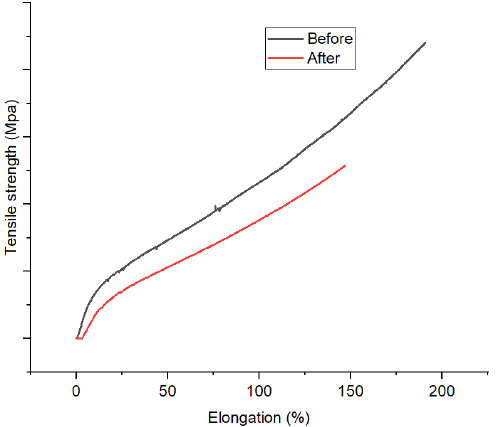
Figure 13. Mechanical profile 1,10-phenanthroline-immobilized PU membranes before and after used for Pb 2+ analysis.